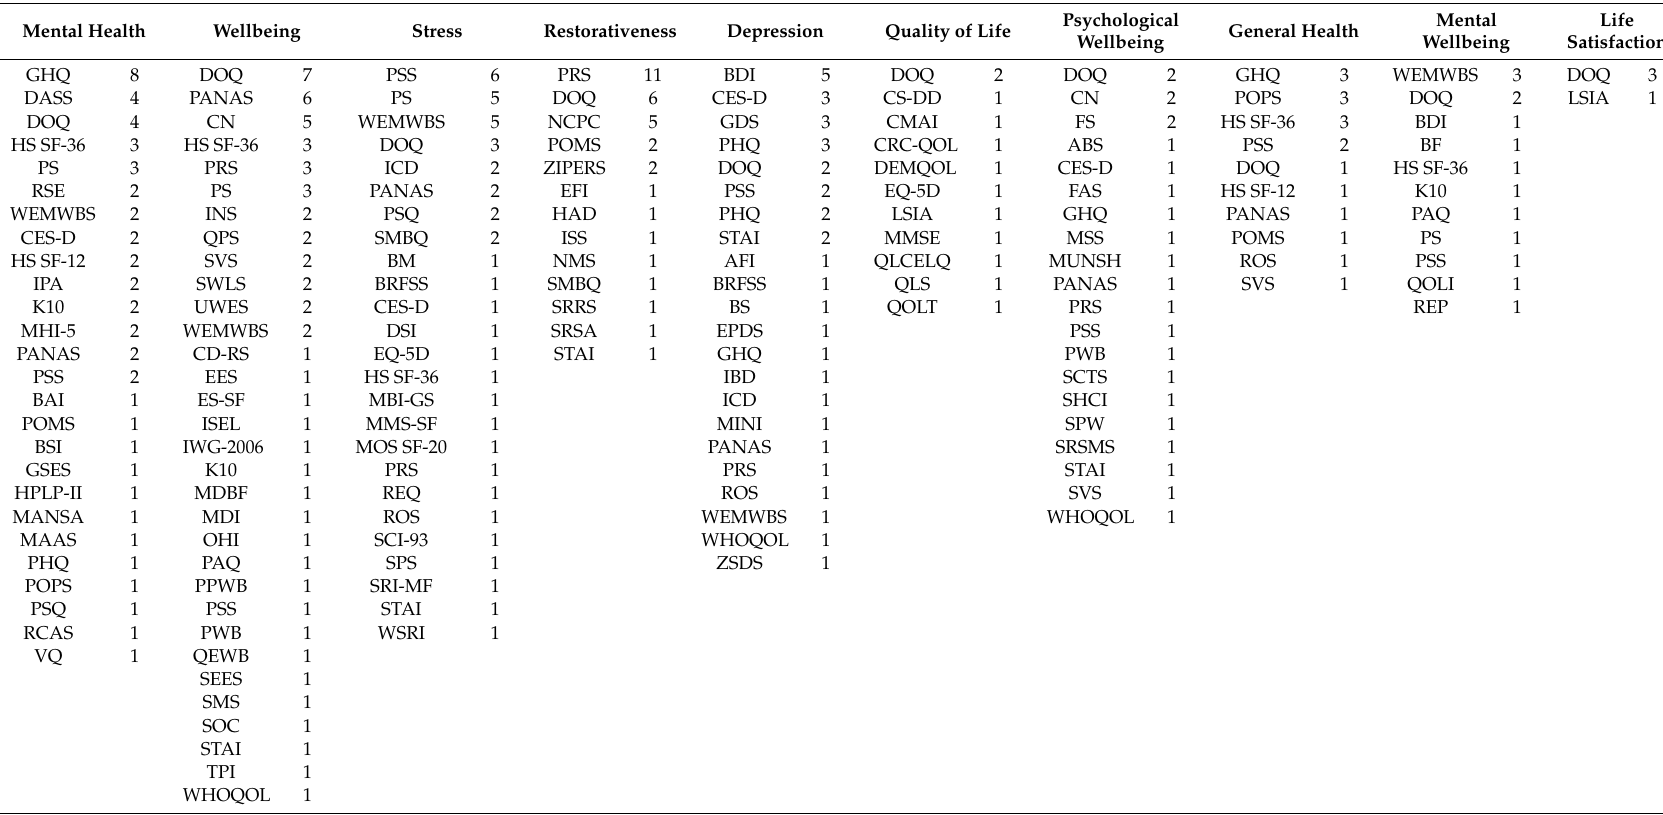
Table 9. Overview of the ten most used health endpoints and the tools most commonly used to assess them – the number next to the tool is the number of studies where it was